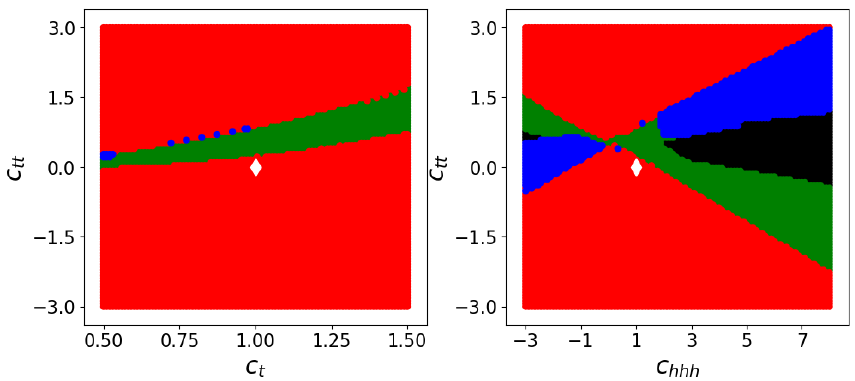
Figure 3 . The parameter regions associated to each shape type in the c t (cid:0) c tt (left) and c hhh (cid:0) c tt (right) parameter spaces. For the colour code we refer to (cid:12)gure 1.